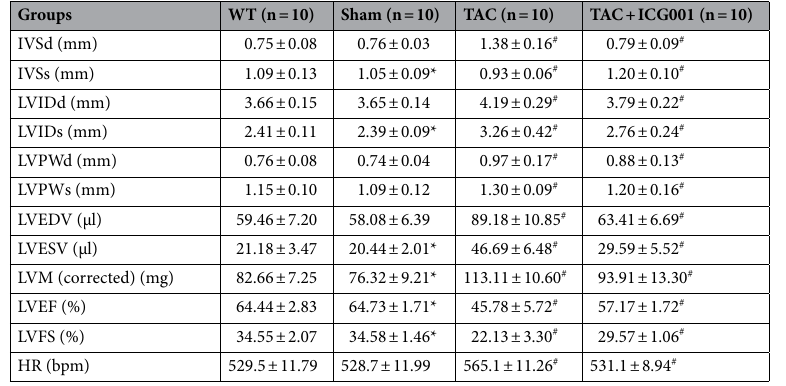
Table 1. Echocardiographic measurements in mice of each group. Statistical significance of distributed data was analyzed by one-way ANOVA followed by Tukey’s multiple comparisons test (n = 10 per group). IVSd interventricular septum depth at end-diastole; IVSs interventricular septum depth at end-systole; LVIDd left ventricular internal diameter at end-diastole; LVIDs left ventricular internal dimension at end-systole; LVPWd left ventricular posterior wall depth at end-diastole; LVPWs left ventricular posterior wall depth at end-systole; LVEDV left ventricular end-diastolic volume; LVESV left ventricular end-systolic volume; LVM left ventricular mass (corrected); LVEF left ventricular ejection fraction; LVFS left ventricular fractional shortening; HR heart rate; bpm beats per minute. * P < 0.05 sham vs. ICG001. # P < 0.05 vehicle (untreated TAC mice) vs.